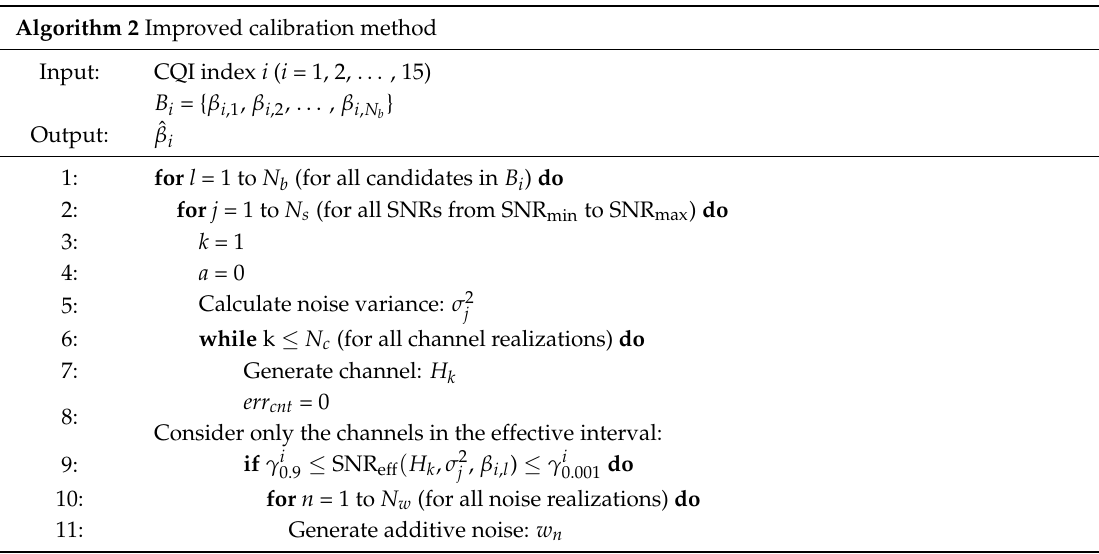
Algorithm 2 Improved calibration method